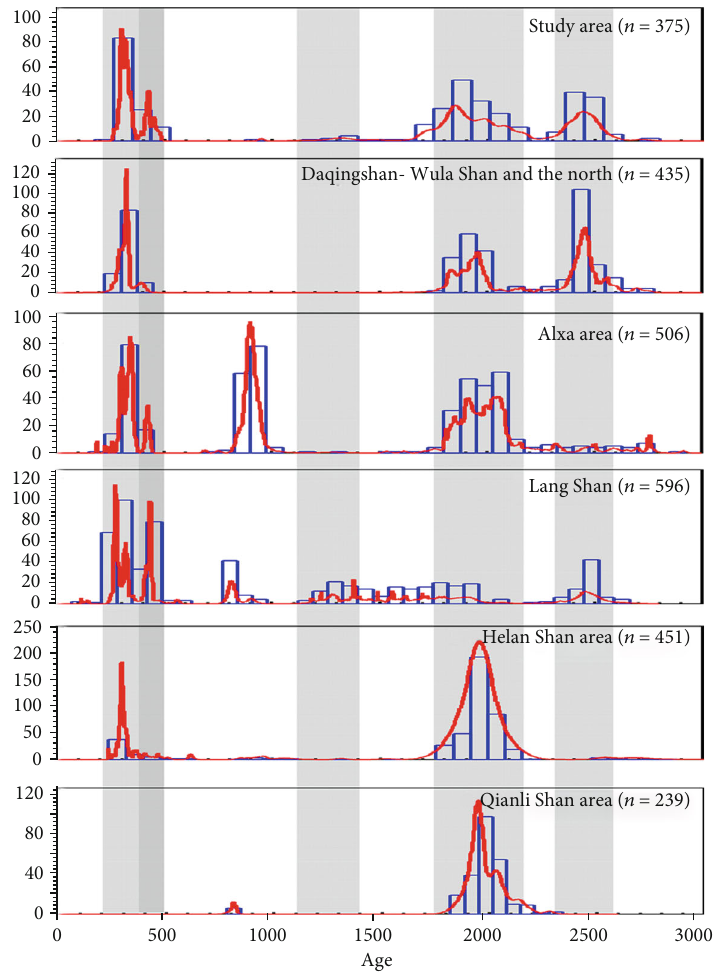
Figure 5: Comparison of zircon ages in the study area and the possible provenance area (Data quoted from YI et al., 2009, 2011; Peng Peng et al., 2018; Wang Zhining, 2018; Zhang Yun et al., 2019; [32]; Peng Runmin et al., 2010; Bao et al., 2019; [21]; Yang Qidi et al., 2014; [32 – 34]; Zhang Qiao et al., 2018; Wang Huichu et al., 2012; Wu Changhua et al., 2006; Liu Jianhui et al., 2013; [7]; Liu Li et al., 2012; [11]; Liu Chao et al.,